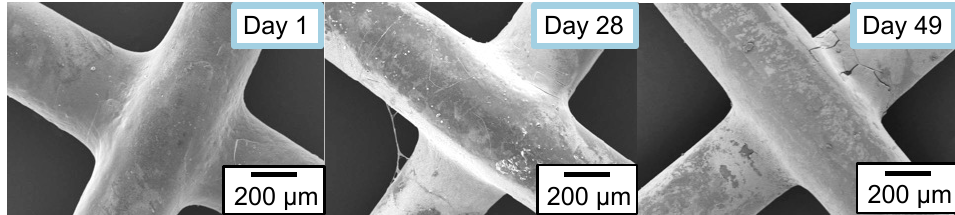
Figure 7. SEM images of the HDTMS-TiO 2 net left outside for 1, 28, and 49 days.